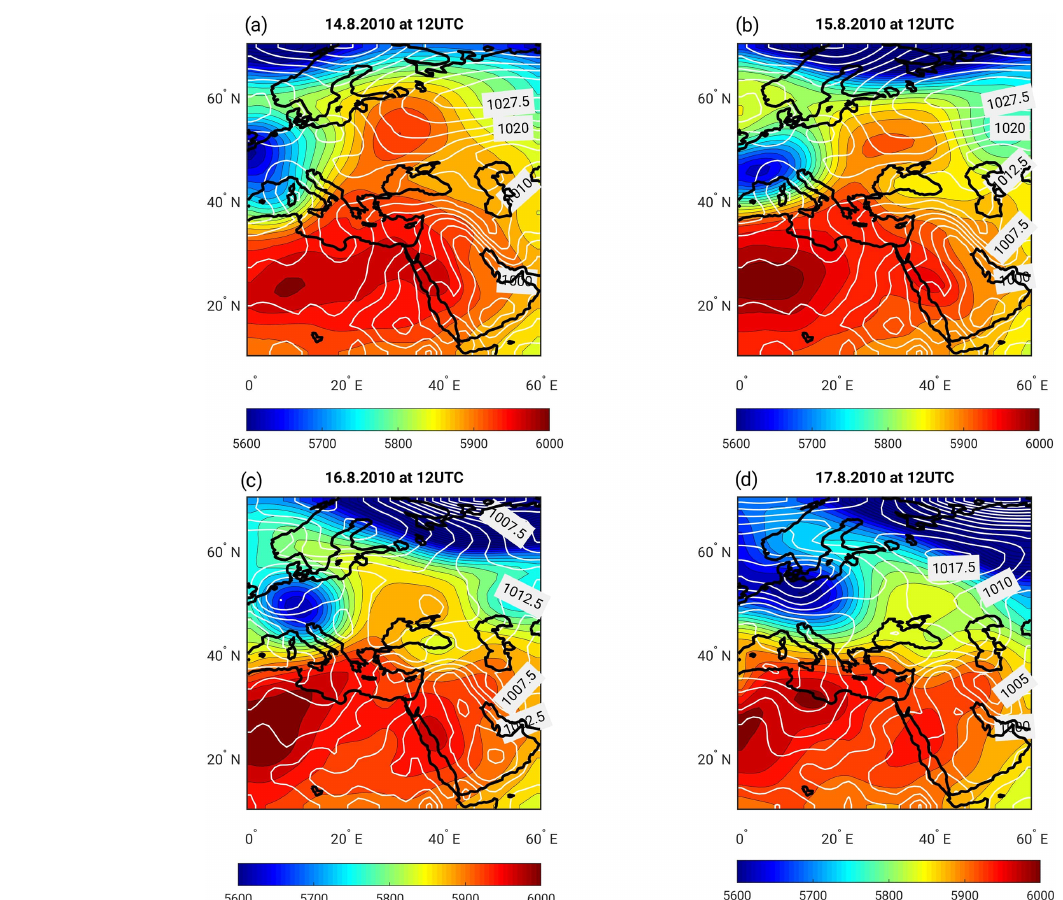
Figure 8. The large-scale evolution of SLP (white contours, in hPa) and Z 500 (shading, in m) for the mid-August 2010 heat wave: (a) 14 Au- gust 2010 at 12:00UTC, (b) 15 August 2010 at 12:00UTC, (c) 16 August 2010 at 12:00UTC and (d) 17 August 2010 at